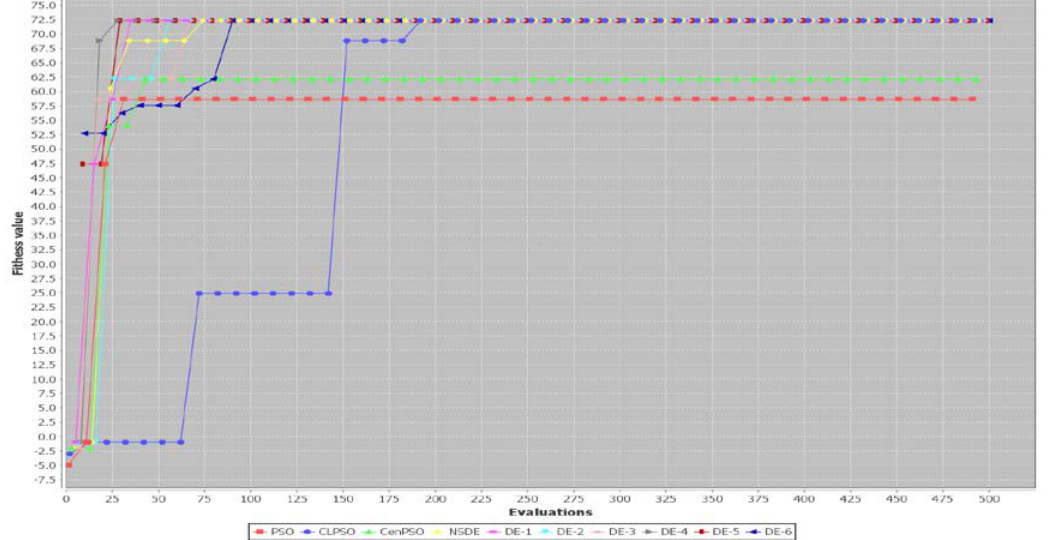
Figure A6. Convergence speed of a run of each algorithm for Case 6 with POP = 30.